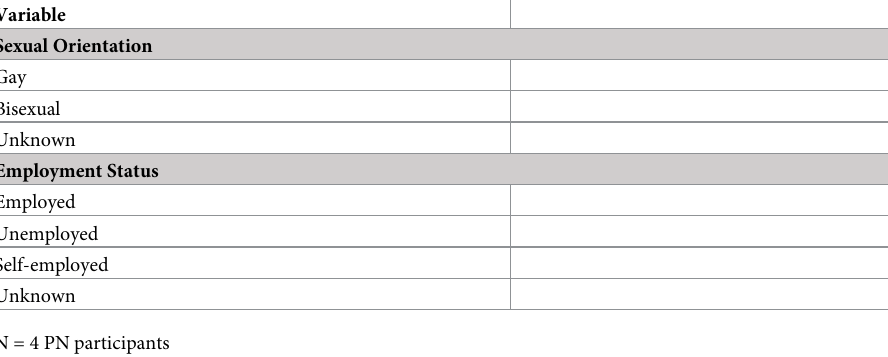
Table 3. PN participant